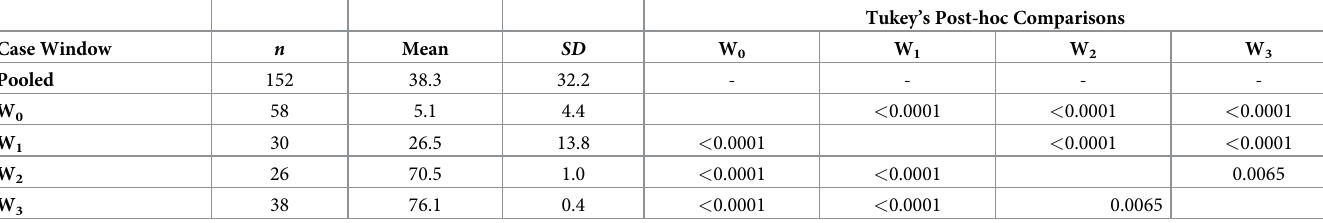
Table 6. One-way analysis of variance of the containment and health index by case window, Nigeria.